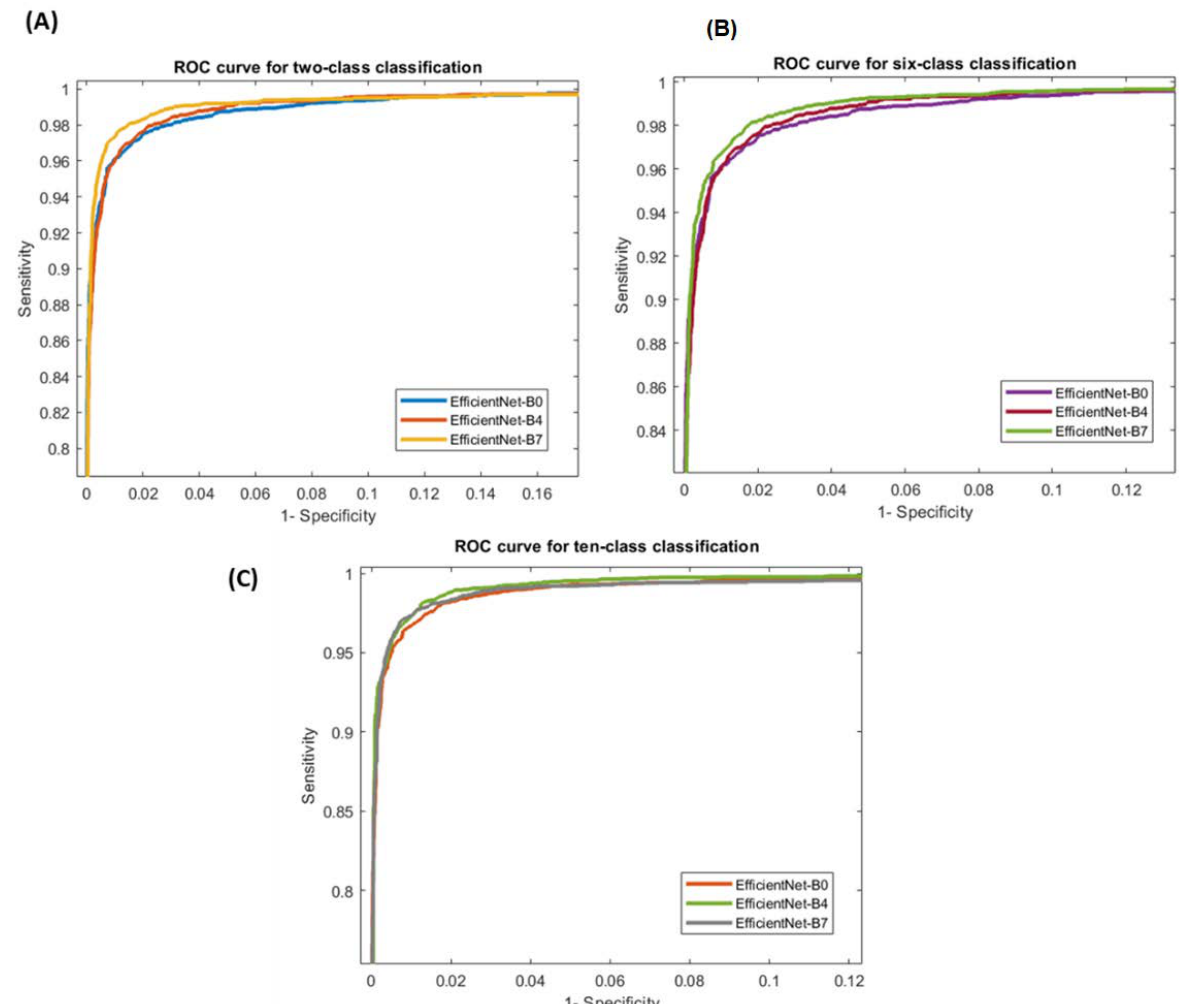
Figure 6. Comparison of the ROC curves for ( A ) binary classification for segmented leaf, ( B ) six-class classification segmented leaf, and ( C ) ten-class classification segmented